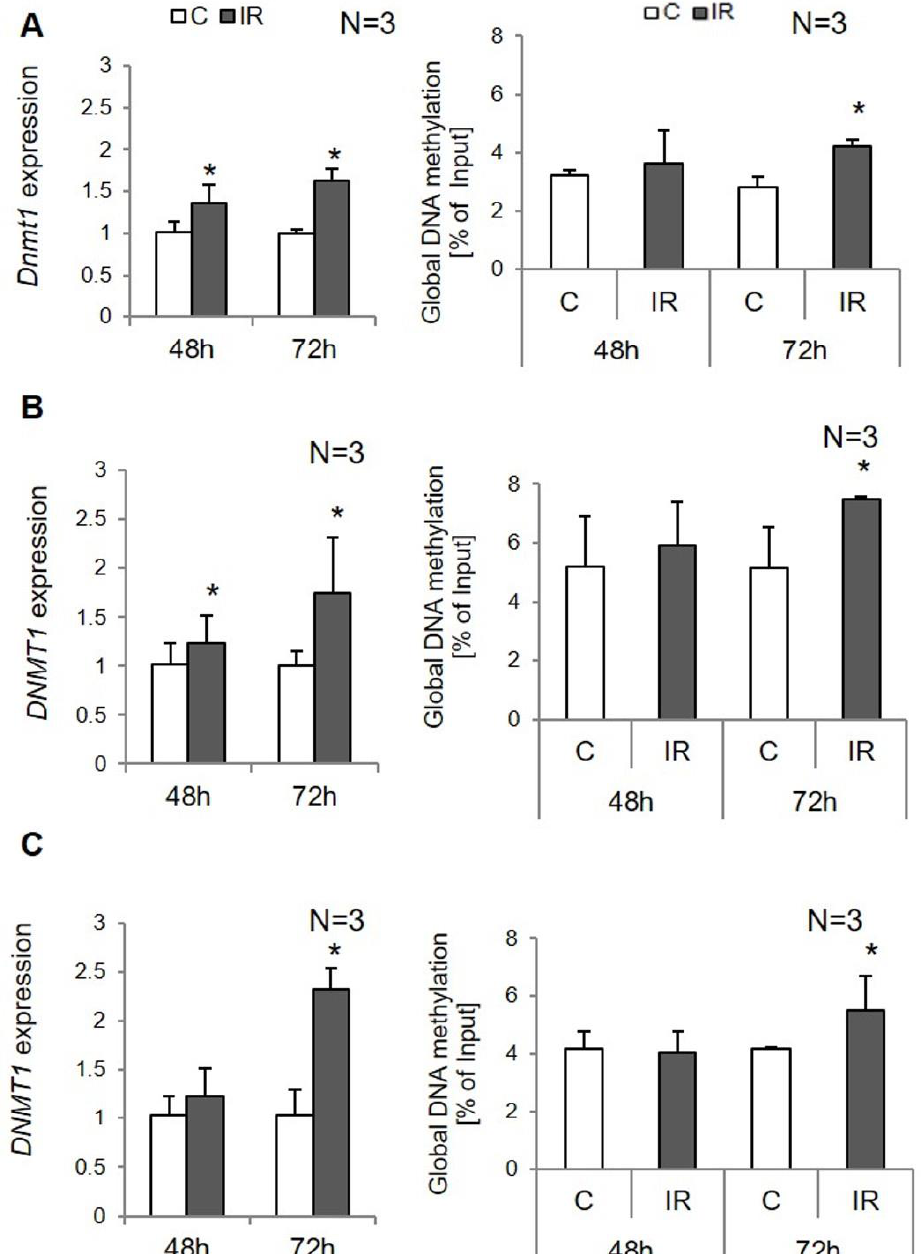
Figure 2. The DNMT1 expression and global DNA methylation in experimental cells following 48 h and 72 h after insulin resistance induction. Controls (C) and insulin-resistant cells (IR): ( A ) 3T3-L1 adipocytes, ( B ) human SAT-derived adipocytes, ( C ) human VAT-derived adipocytes; gene expression is normalized to β -actin gene, * p < 0.05.